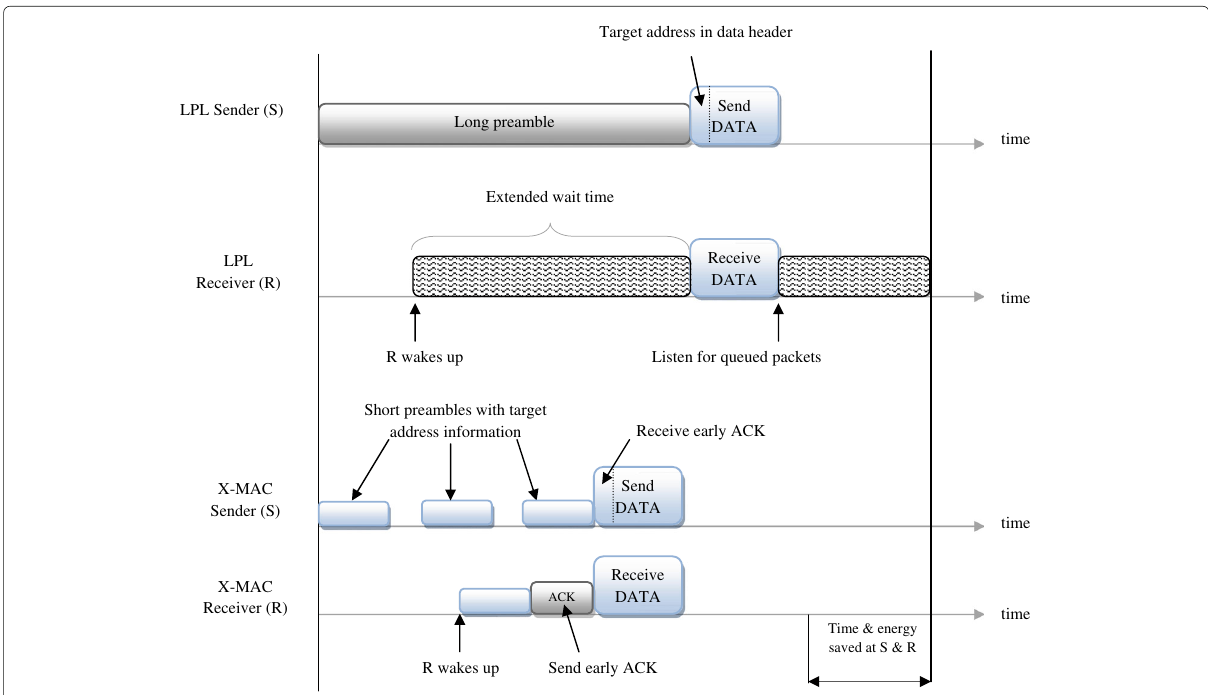
Fig. 2 The timelines LPL and X-MAC protocol for the short preamble approach